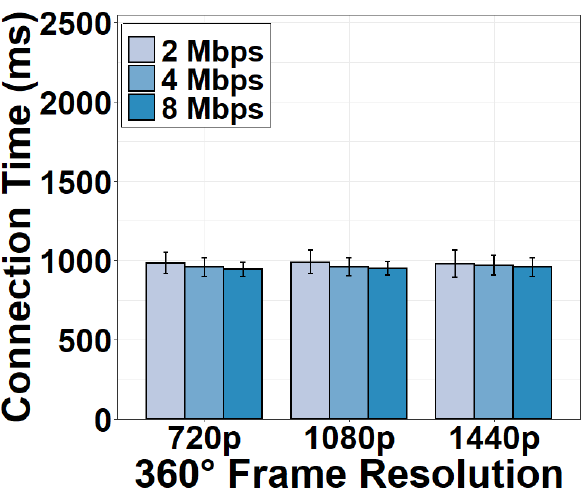
Figure 13. Connection time under different download